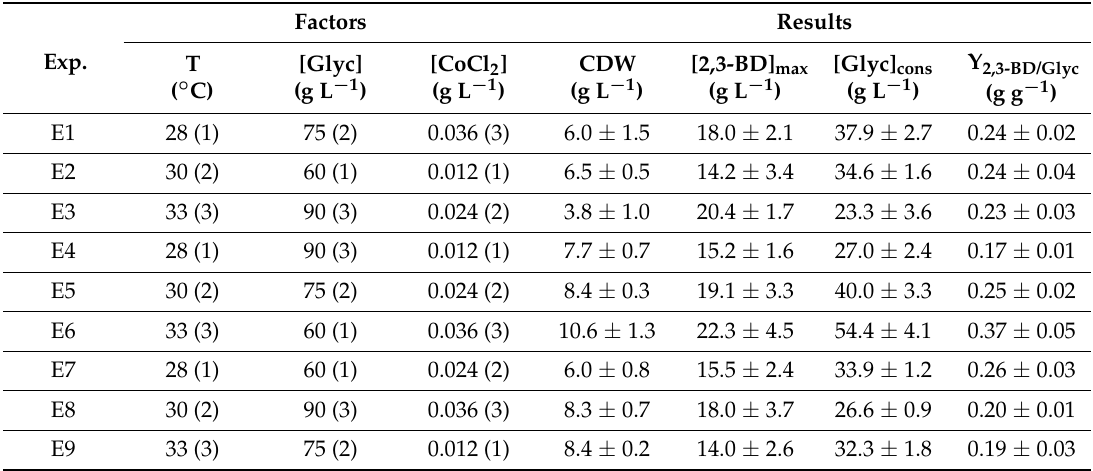
Table 1. Experimental layout using an L 9 Orthogonal Array. Selected parameters and their levels.